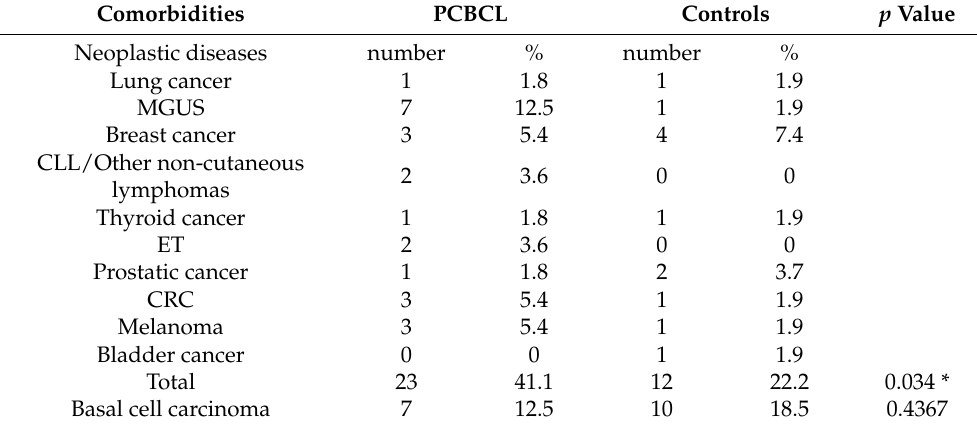
Table 2. Frequency of neoplastic diseases in patients with PCBCL and controls.